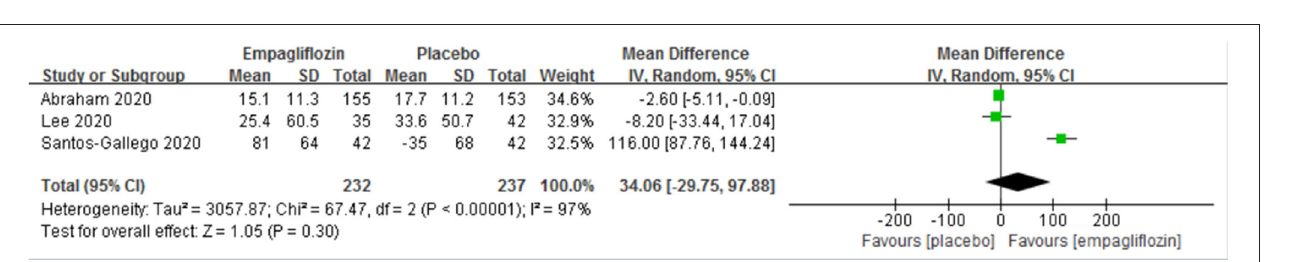
FIGURE 3 | Effect of empagliflozin on hospitalization for worsening heart failure.